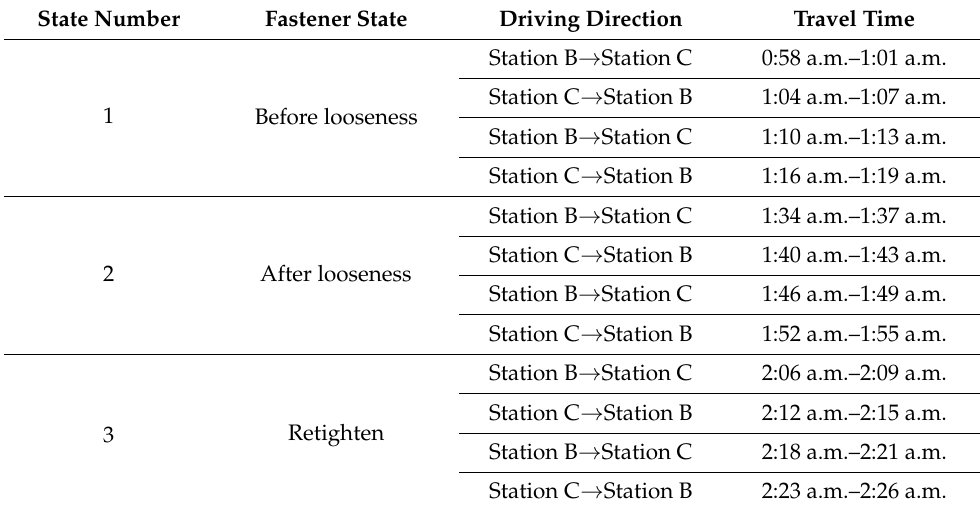
Table 1. Test time record in situ under three fastener states.